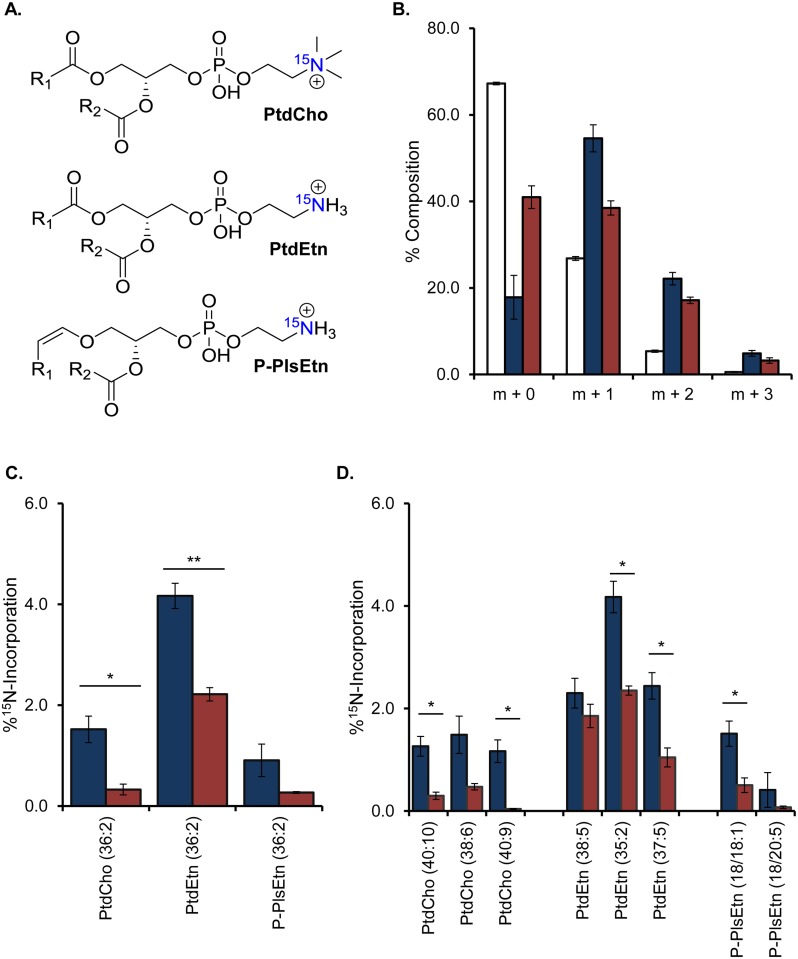

15N-Tracers and LC-MS/MS Measure PL Dynamics in Wild-Type and fat-7 RNAi Animals.(A) Representation of the major PLs in the nematode: phosphatidylethanolamine (PtdEtn), phosphatidylcholine (PtdCho), and plasmenylethanolamine (P-PlsEtn) where R1 and R2 represent aliphatic carbon chains. The single nitrogen is highlighted in blue. (B) LC-MS/MS showed successful incorporation of 15N into the headgroups of PtdEtn (36:2) in labeled (blue) compared to unlabeled (white) control animals. Incorporation of 15N was compromised in this representative example for animals treated with fat-7 RNAi (red). (C) The enrichment of 15N seen in each PL was modeled by % 15N-labeled PL per hour. The incorporation of 15N was significantly lower in fat-7 RNAi treated animals (red) compared to control (blue). (D) The amount of new FAs for the most abundant species from each PL class is shown for control (blue) and fat-7 RNAi treatment (red) as well. Data shown represent SEM and a minimum of n of 3. Significance was defined by two-tailed unpaired t-tests (*p<0.05, **p<0.01).